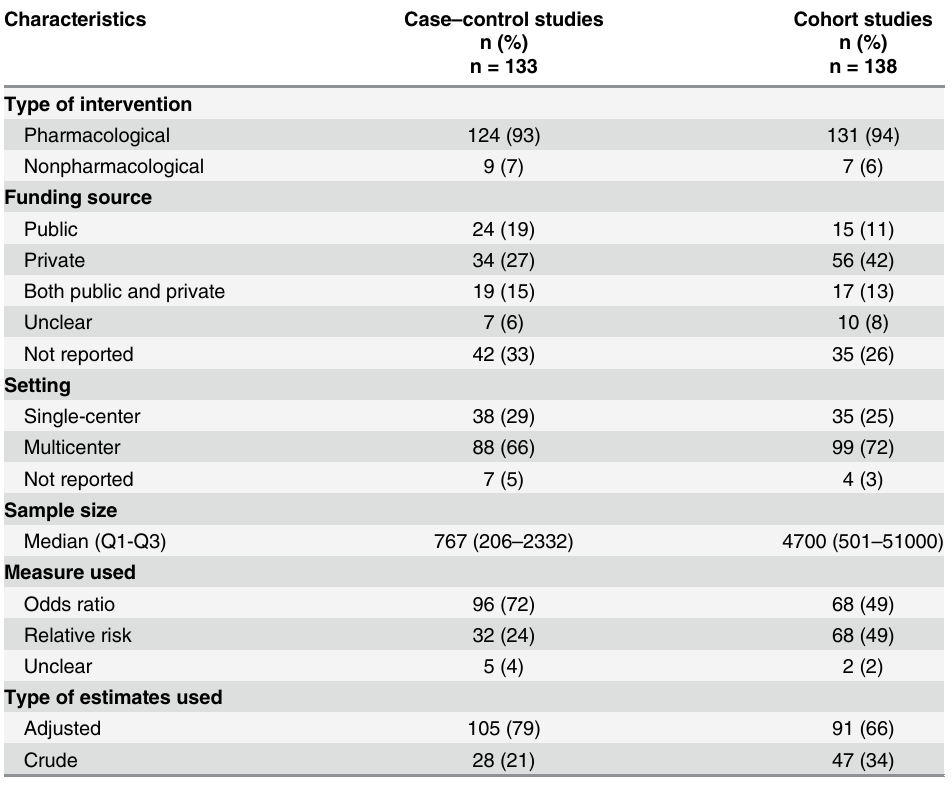
Table 1. Characteristics of cohort and case – control